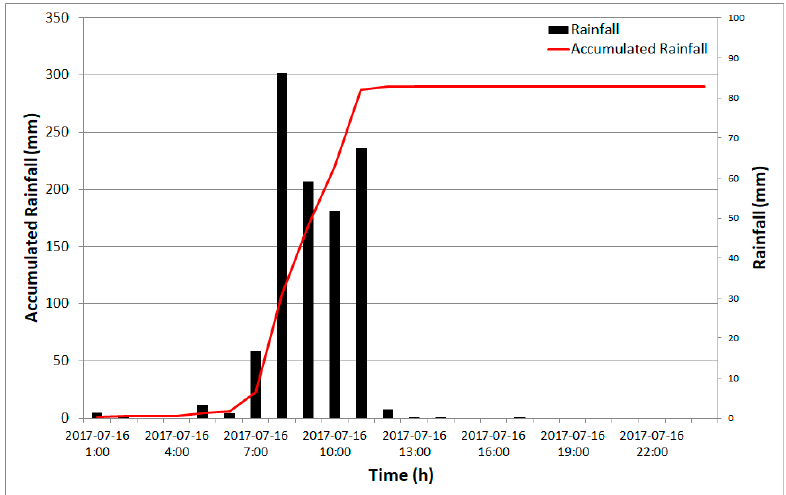
Figure 19. Hyetograph (Case 3).